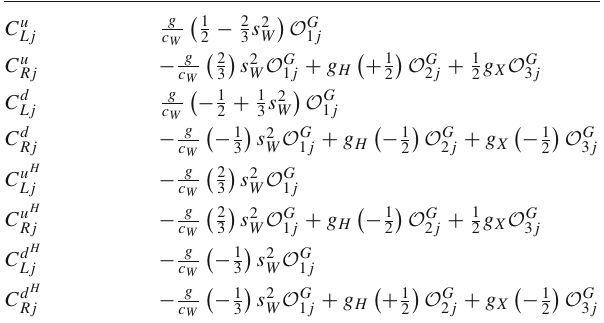
and C f for quarks Lj Rj